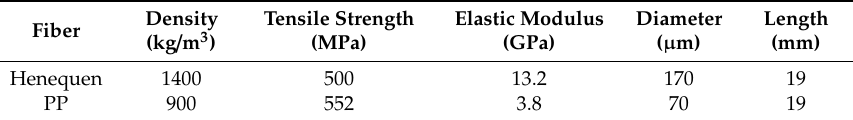
Table 3. Foamed concrete mixtures for the mechanical characterization.